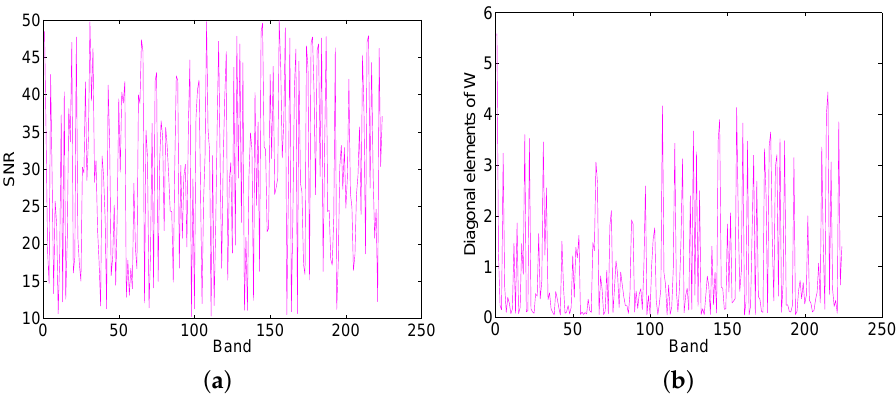
Figure 16. ( a ) The SNR of different band of the generated HSI and ( b ) diagonal elements of the weighting matrix using proposed SU-NLE in simulated experiment IV.